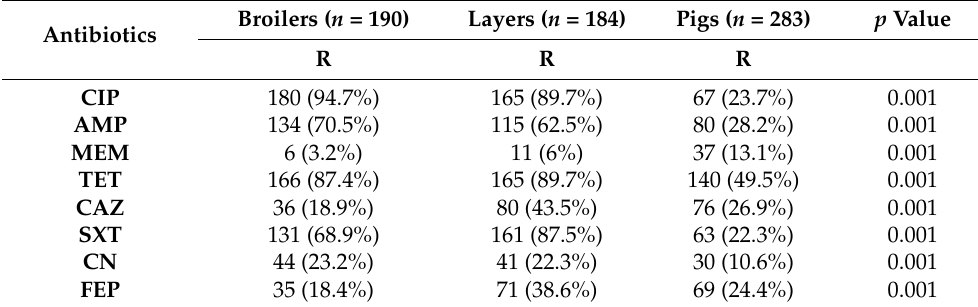
Table 3. Percentage susceptibility of E. coli to antibiotic agents tested.